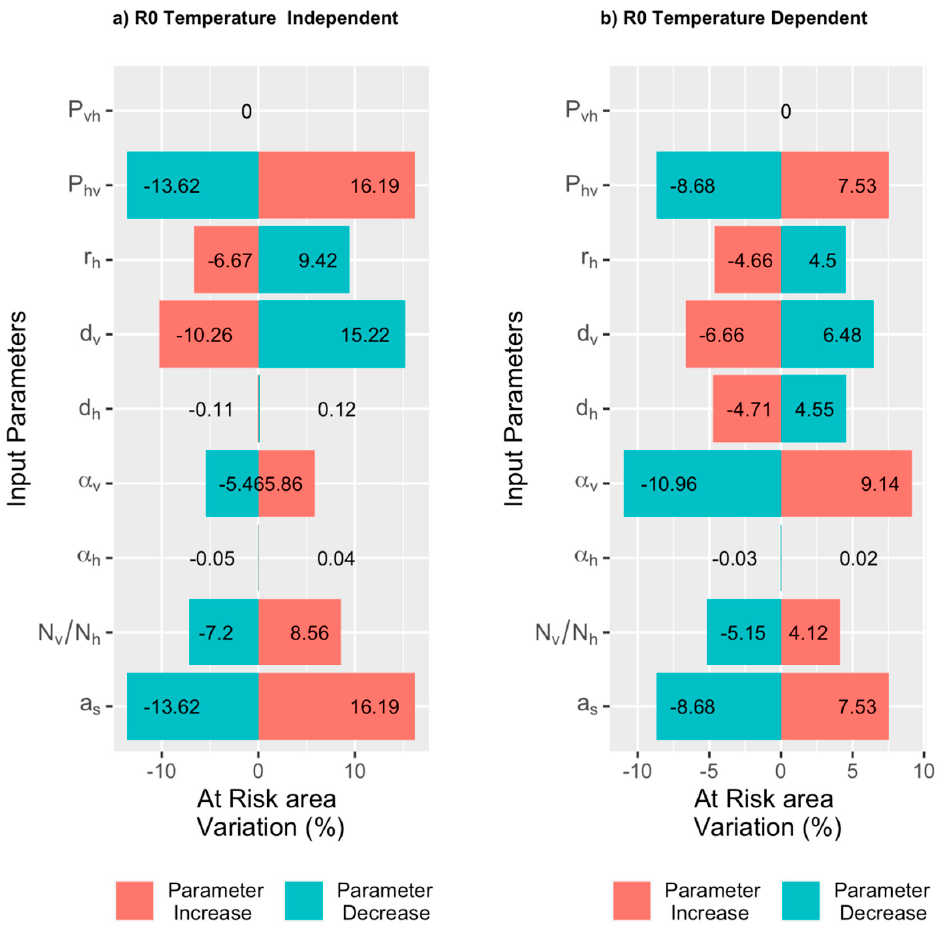
Figure 6. Tornado plot of sensitivity analysis in the 2 cases when parameters used in the model are temperature-independent ( a ) or temperature-dependent ( b ). The name of the epidemiological parameters that are varied on shown on the y-axis. The variation in the number of pixels at risk is shown on the x-axis. For each parameter, the bars represent the variation in the number of at risk pixels following a decrease or increase in a parameter value. The color of the bar indicates if the variation in the number of pixels at risk is due to an increase (red) or a decrease (blue) in the corresponding parameter value. The length of the bar is proportional to the variation in the number of pixels at risk (expressed as a